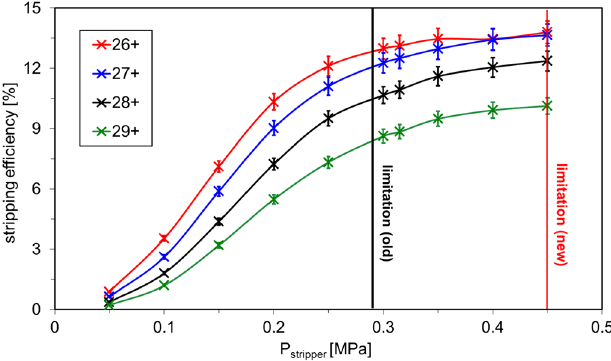
FIG. 3. Measured high current uranium beam stripping efficiency as a function of the stripper target density (prepres- sure); N 2 -supersonic gas jet with enlarged beam apertures (22 mm)